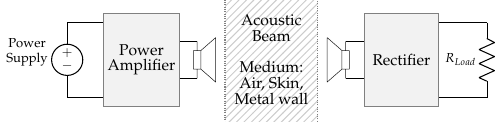
Figure 24. Basic structure of an APT